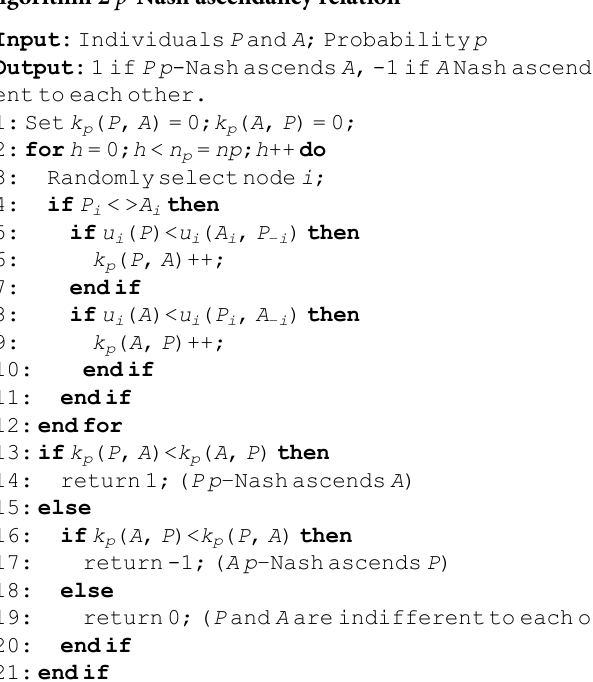
Algorithm 2 p - Nash ascendancy relation